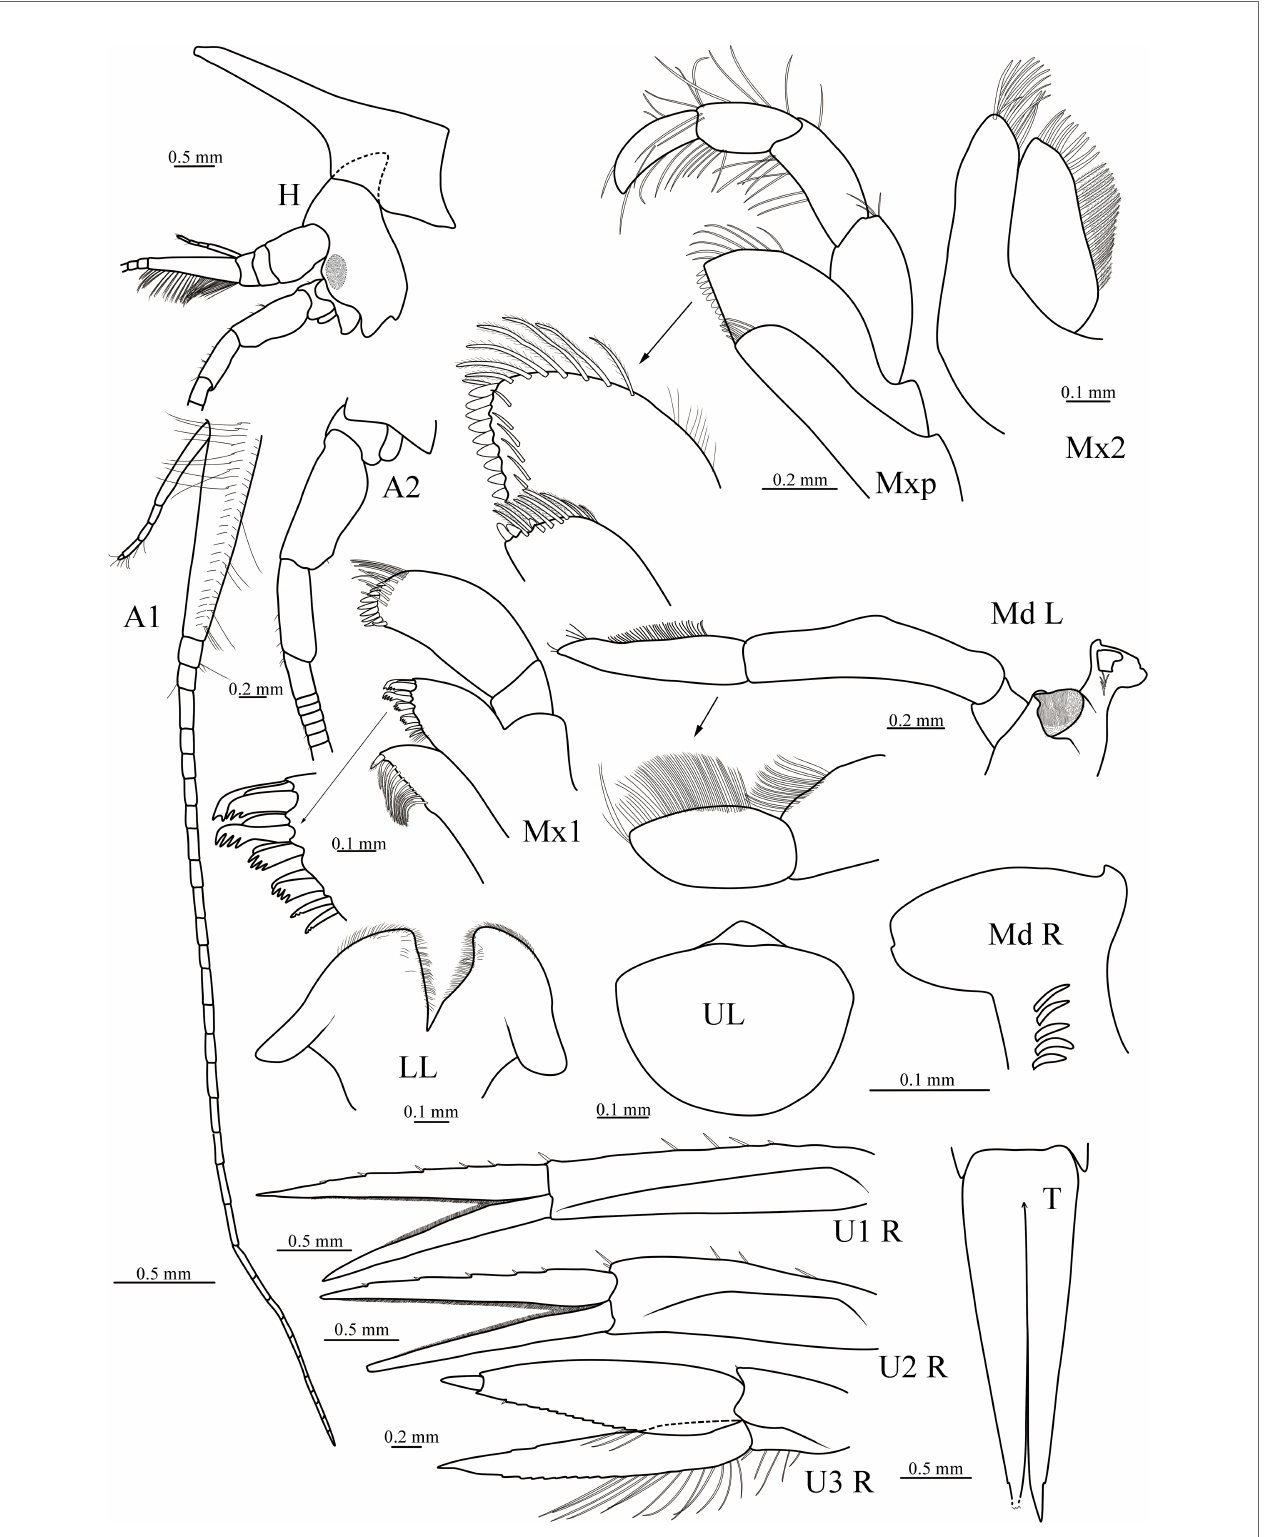
FIGURE 5 | Cyphocaris formosa sp. nov., MBM 286820, male holotype (19 mm), showing head, antenna 1 and 2, mouthparts, uropod 1 – 3 and telson. For abbreviations, see